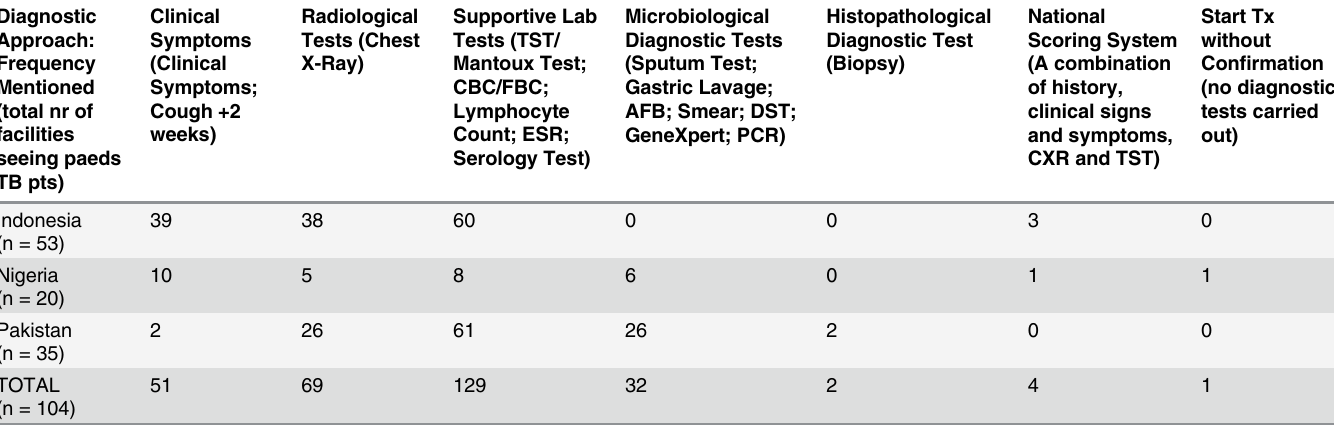
Table 4. Diagnostic Tests requested by healthcare practitioners when faced with a suspect case of paediatric TB (several tests may be requested for one child). Diagnostic